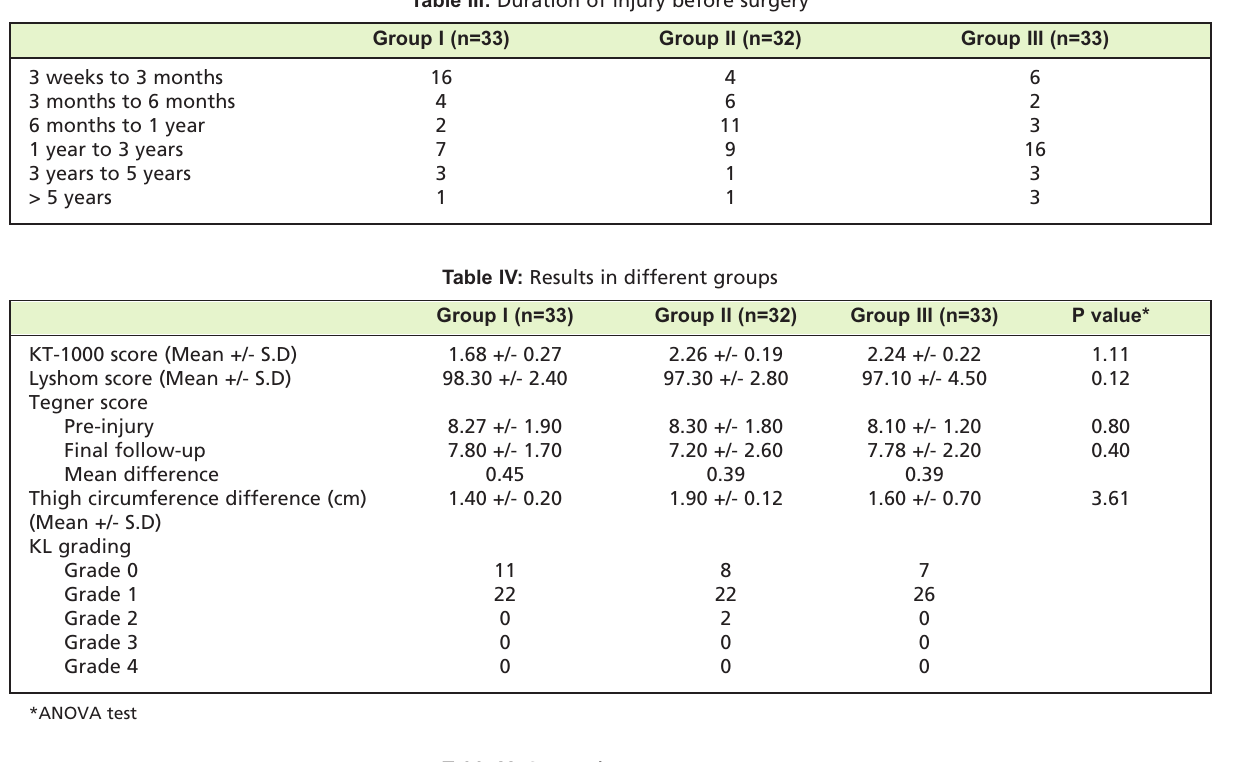
Comparison among Table V: